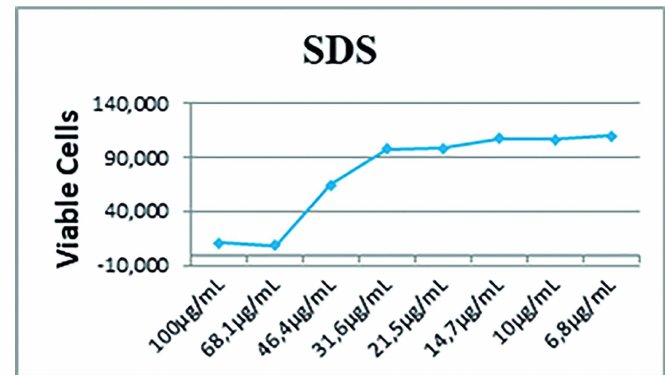
Figure 8. SDS curves on different dilutions of evaluated cells.